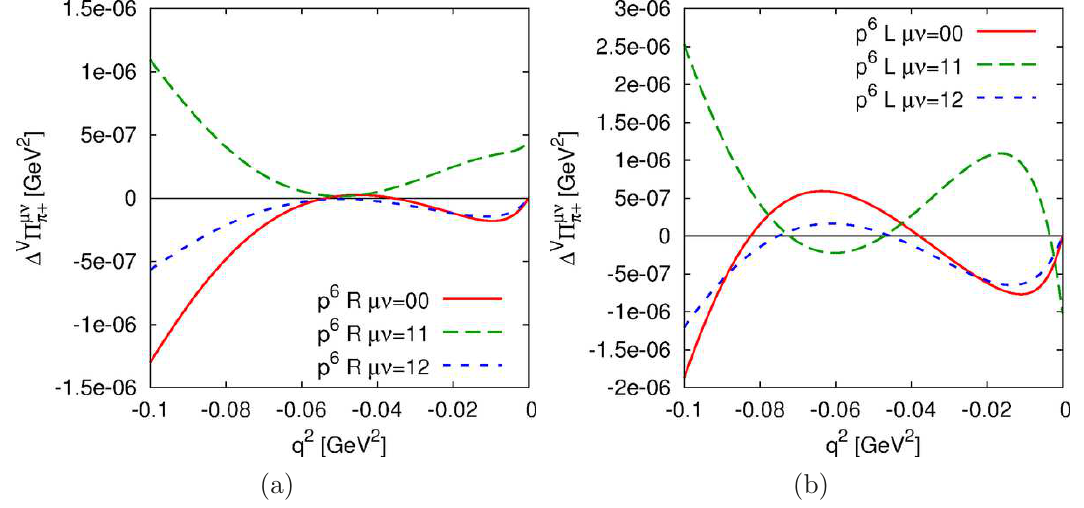
Figure 5 . The parts of the finite volume corrections at p 6 for the spatially symmetric case (a) p 6 R (b) p 6 L